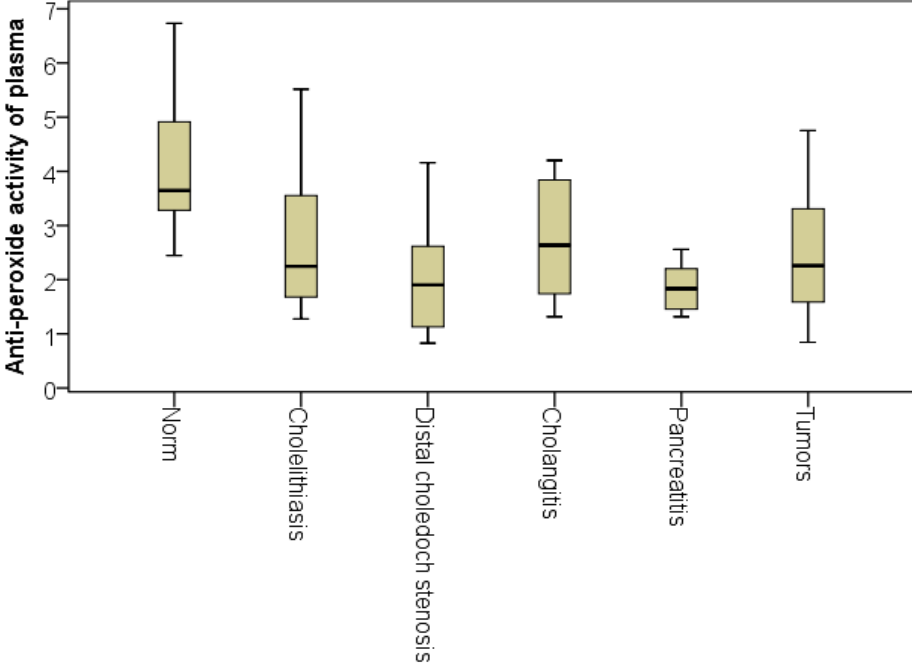
Figure 4. Plasma APA indices for various etiologies of obstructive jaundice.